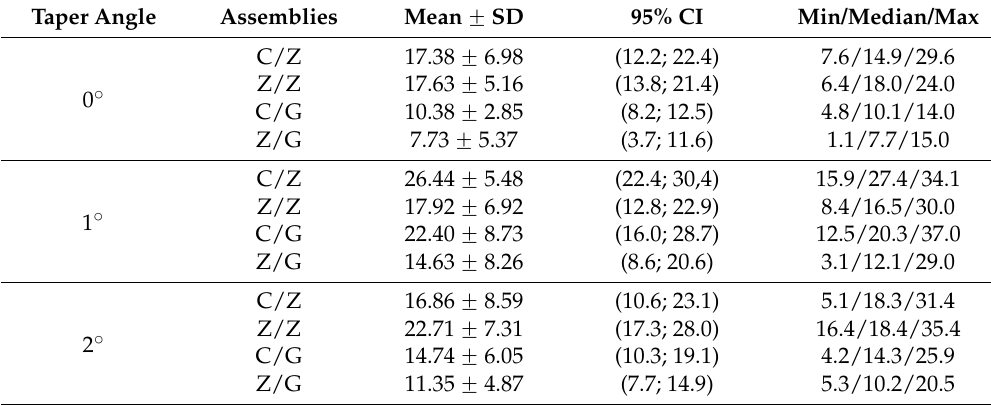
Table 1. Descriptive statistics such as mean with standard deviation (SD), 95% confidence intervals (95% CI) and the non-parametric statistics (minimum/median/maximum). All values are presented in Newton